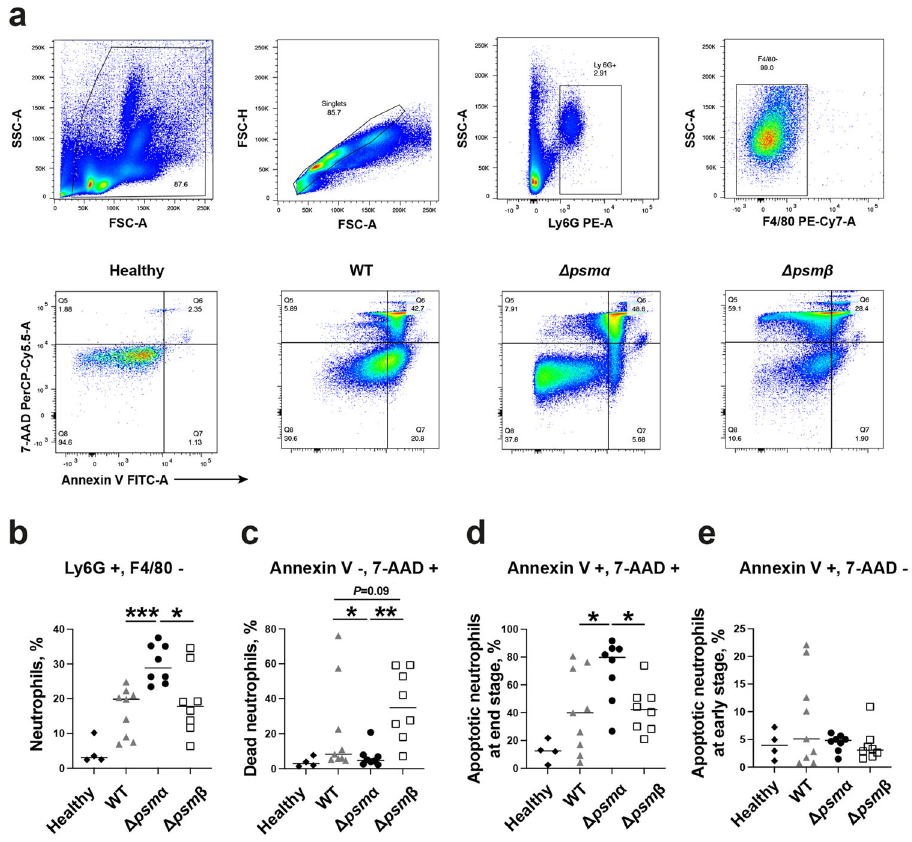
Fig. 8 Neutrophil apoptosis and death in S. aureus PSM mutants infected mice. Blood samples were collected for fl owcytometry analyses from NMRI mice ( n = 8 – 9/group) after intravenous infection with S. aureus Newman (wild type, WT), or the isogenic mutant strains Δ psm α or Δ psm β